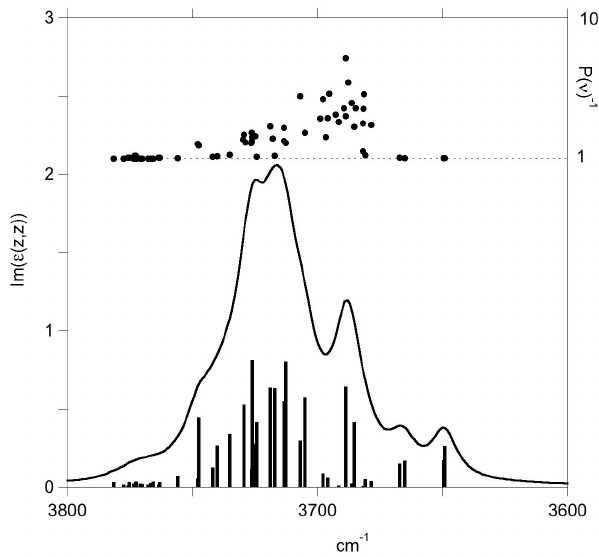
Figure 6. Imaginary part of the diagonal element ( z,z ) of the antig- orite dielectric tensor reported as a function of frequency in the OH stretching range. The IR activities of the vibrational modes (10 · (D/ Å ) 2 /amu on the left vertical scale) are reported as vertical sticks at the bottom of the figure. The participation factors P(ν) − 1 of the modes are reported as circles with values on the right verti- cal scale. Note the localized character ( P(ν) − 1 ≈ 1) of stretching modes related to inner OH groups observed on the high-frequency side of the spectrum and the presence of localized modes associated with 8-reversals on the low-frequency